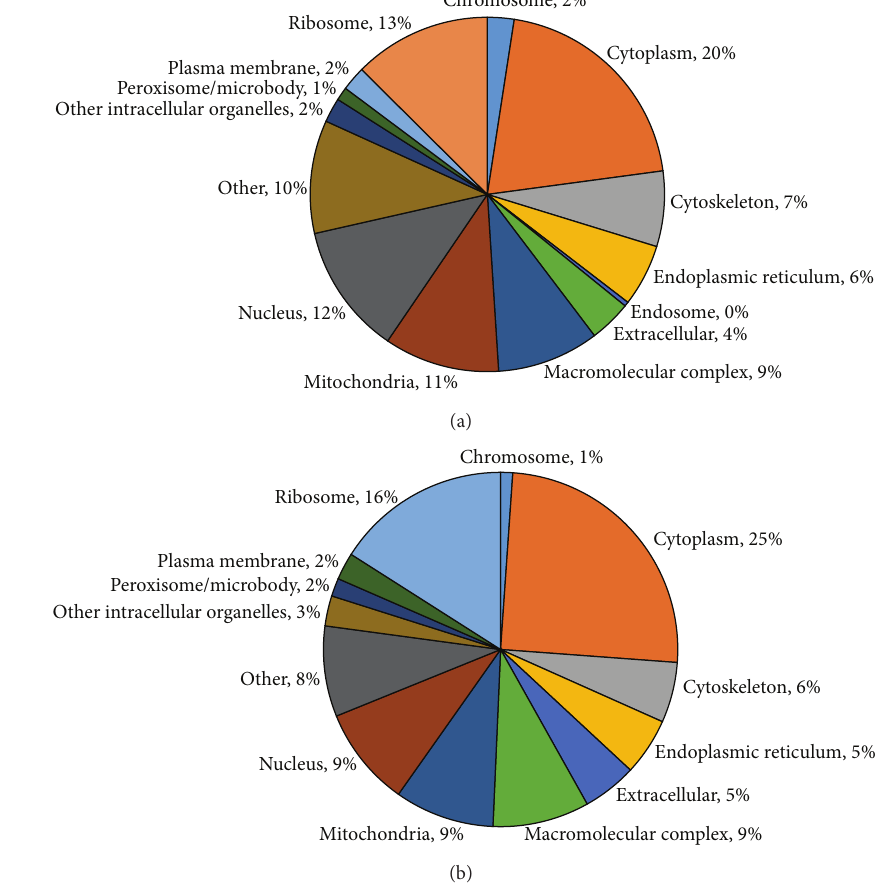
Figure 3: Subcellular localization of the identified proteins based on GO analysis. (a) 881 proteins identified in DOC Δ X samples; (b) 659 proteins identified in SDS Δ X samples generated using STRAP. The identified subcellular localization profiles are largely similar between both samples, with only the DOC Δ X samples having proteins located in the endosome. The larger number of proteins identified from the DOC Δ X samples also showed more even distribution of proteins across all subcellular locations. Percentages are rounded to the nearest whole